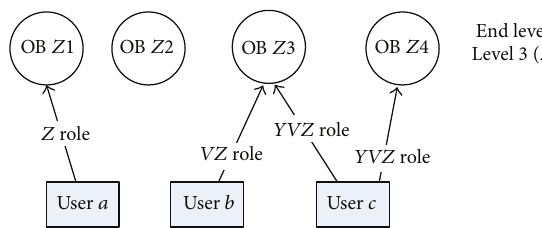
Figure8:RelationsbetweenusersandobjectsinthefinalFPSNafter the top-bottom flattening process.